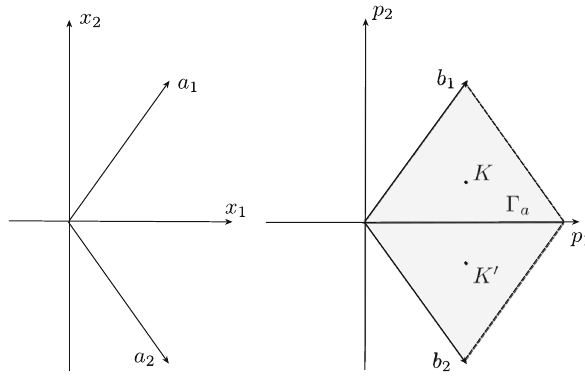
Fig. 3 Lattice vectors, reciprocal lattice vectors, the fundamental domain Γ a , and the Dirac points K and K